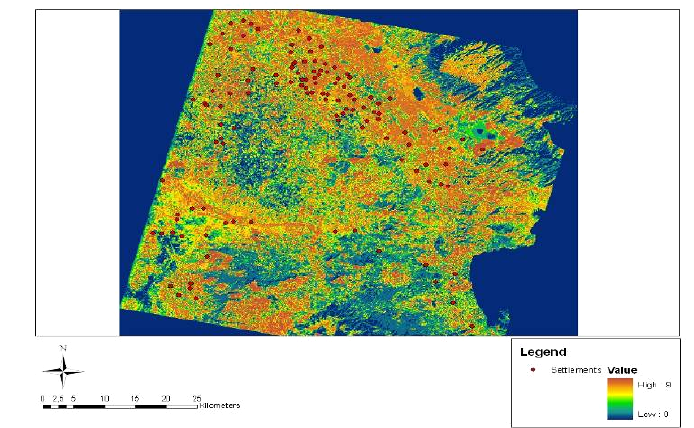
Figure 7. Classification map from the spectral signatures of ASTER